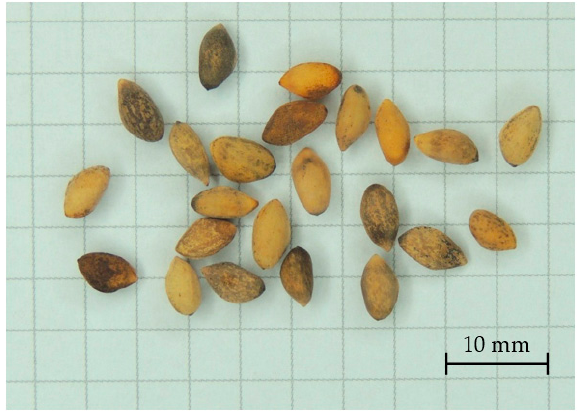
Figure 1. Black pine seeds.